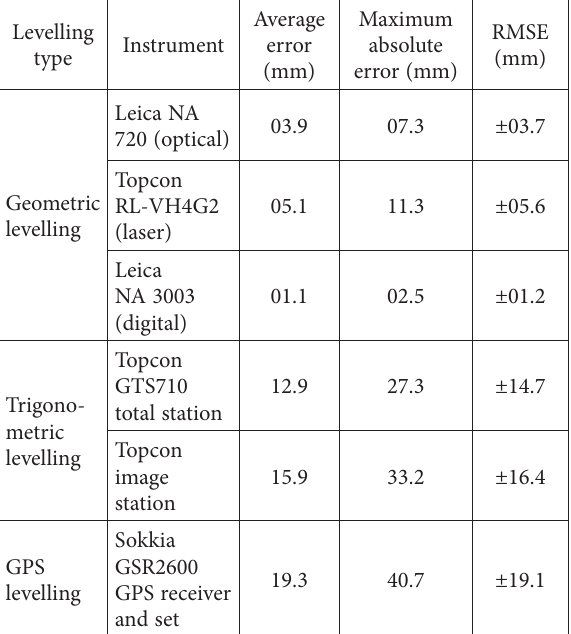
Table 5. Comparison of the accuracy of levelling methods Levelling type